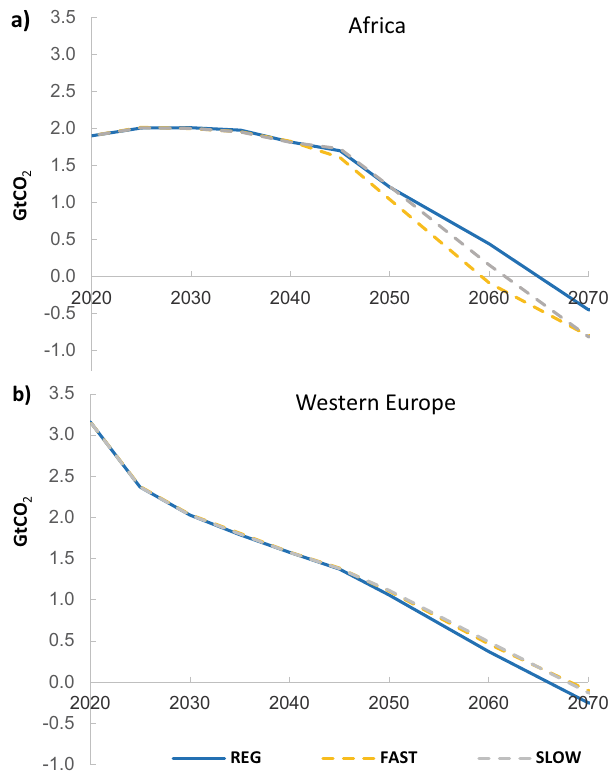
Fig. 6 CO 2 emissions for the 2 °C scenarios with different WACC reduction rates. The panels show CO 2 emissions for the 2 °C scenarios with different WACC reduction rates for ( a ) Africa and ( b ) Western